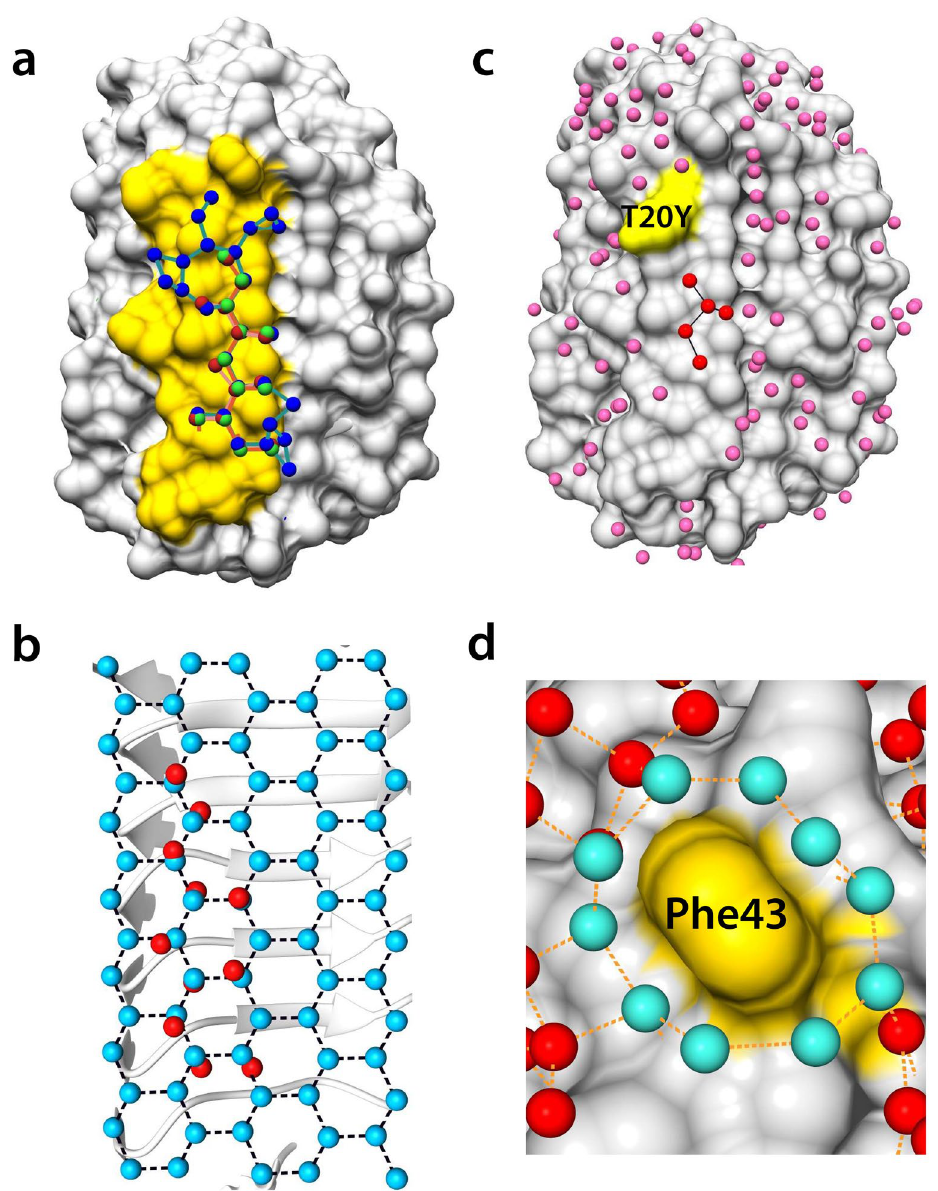
Figure 6. Bound water network and superposition on the basal ice-plane water. ( a ) Surface structure of Tis AFP7, with bound water molecules in the loop region of ice-binding site (IBS) colored in yellow. The bound water molecules in Tis AFP7, Tis AFP8, and Tis AFP6 are drawn as spheres in red, blue, and green, respectively. Proximal water molecules, within 3.7 Å, are connected by solid lines. ( b ) Eleven bound water molecules at the IBS loop of Tis AFP7 superposed on the basal plane water molecules of an ice crystal with root-mean–squared deviation of 0.77 Å. ( c ) Crystal structure of the T20Y mutant with bound water molecules on its surface. The altered site (Tyr20) is indicated in yellow. IBS water molecules are denoted in red and other bound water molecules in pink. ( d ) Magnified view of Phe43 surrounded by a water ring composed of 10 water molecules drawn in cyan. Each water molecule located within 3.5 Å of each other is connected by a dashed